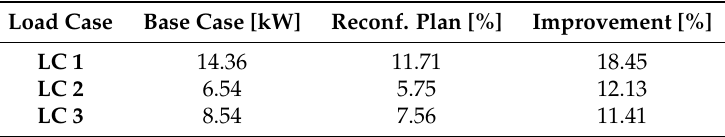
Table 5. Power losses at each load